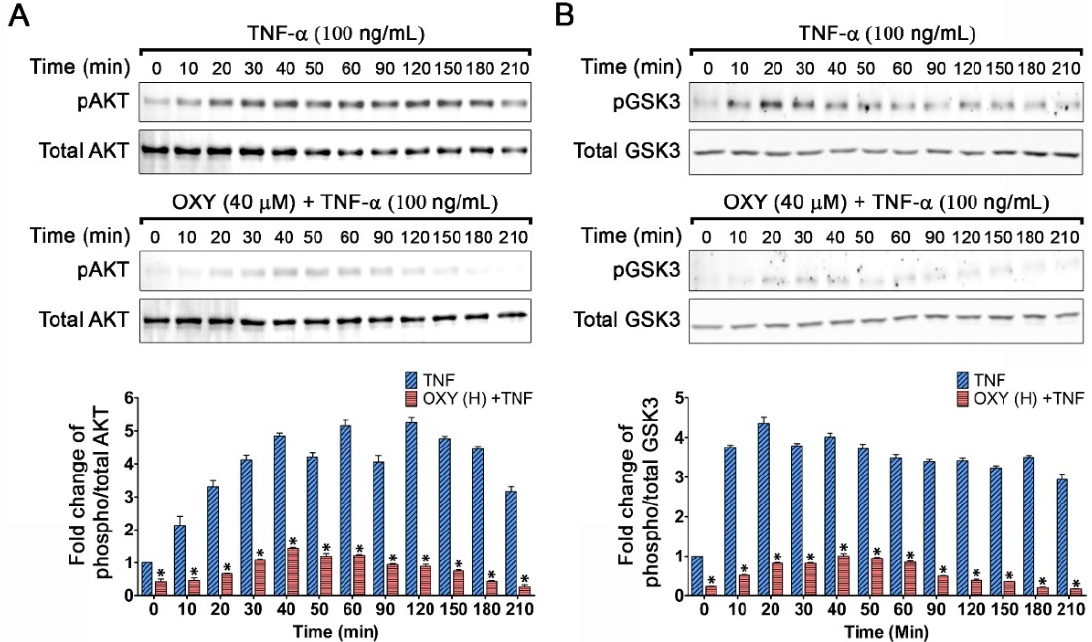
Figure 3. Inhibitory effects of OXY on AKT activation induced by TNF- α . ( A ) Phosphorylation status and quantitative analysis of AKT (pAKT) of HaCaT cells treated with OXY at the highest non-toxic concentration (OXY(H)) which was 40 μ M and stimulated with 100 ng/mL TNF- α at various time points (0–210 min). ( B ) Phosphorylation status and quantitative analysis of GSK3- β (GSK3- β ) of HaCaT cells treated with OXY at the highest non-toxic concentration (OXY(H)) which was 40 µ M and stimulated with 100 ng/mL TNF- α at various time points (0–210 min). * p < 0.05 in comparison to the TNF- α -treated group.